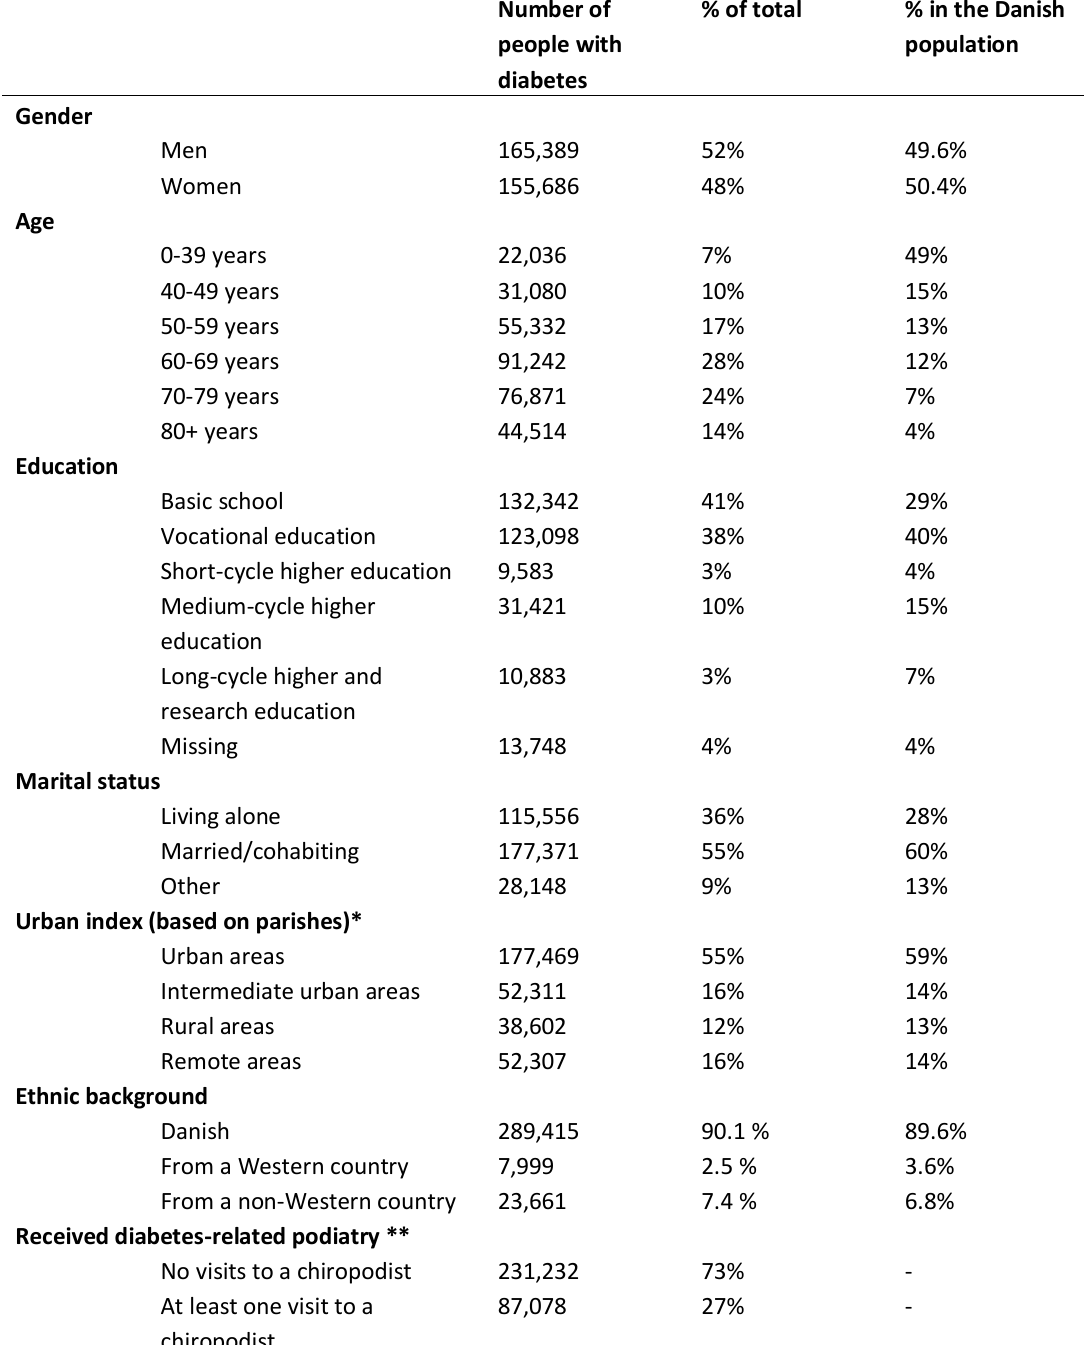
Table 1: Descriptive statistics for people with diabetes compared with the Danish population, 2012 (N=321,075) Number of % of total % in the Danish people with population diabetes Men 165,389 52% 49.6% 155,686